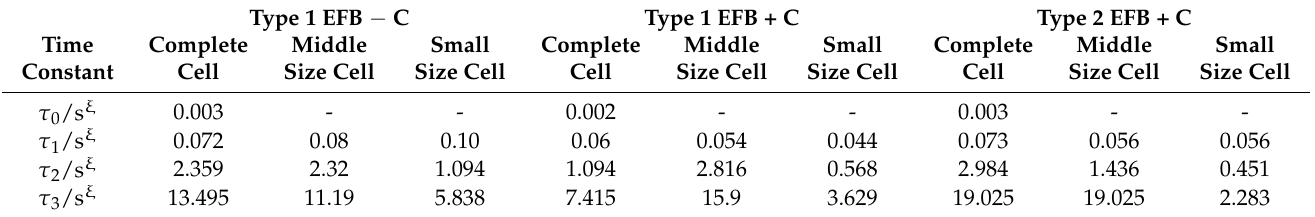
Figure 5. DRT of the EIS at 80% SoC of the laboratory test cells for ( a ) complete cell: 8P8N/8P9N, ( b ) middle size cell: 3P2N and ( c ) small size cell: 2P1N. Table 4. Time constants determined with DRT of the EIS at 80% SoC of the laboratory test cells.